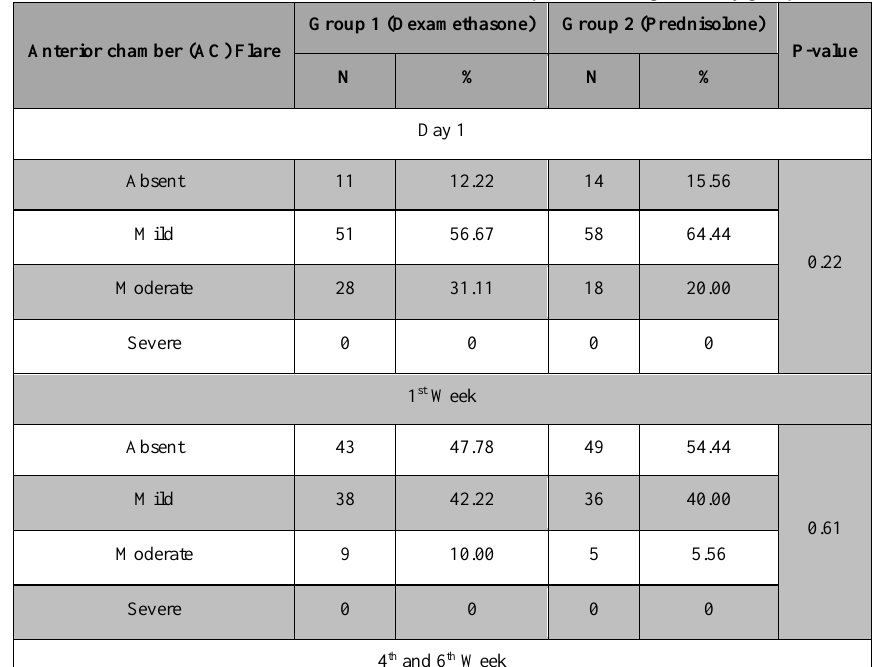
Table 2. Anterior chamber (AC) flare assessment comparison among the study